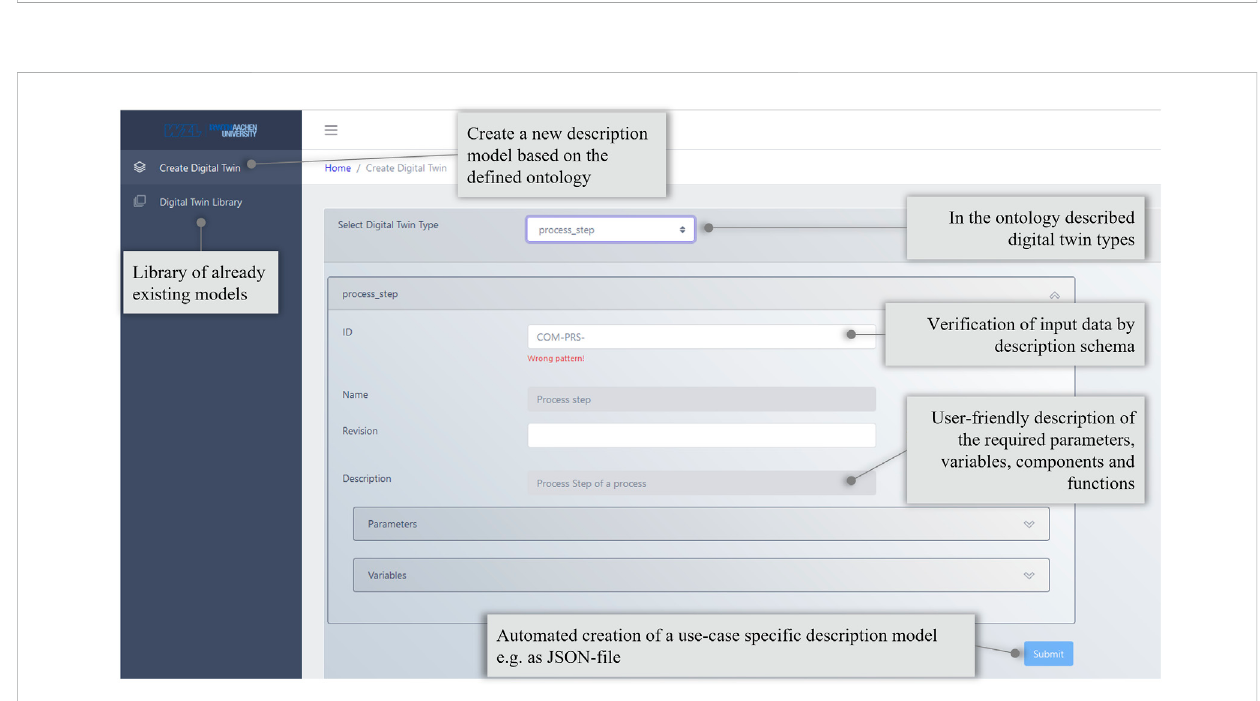
FIGURE 7 Web-based user interface of the model generator to ensure that the manual input follows the given data structure and is directly available in machine-readable form.